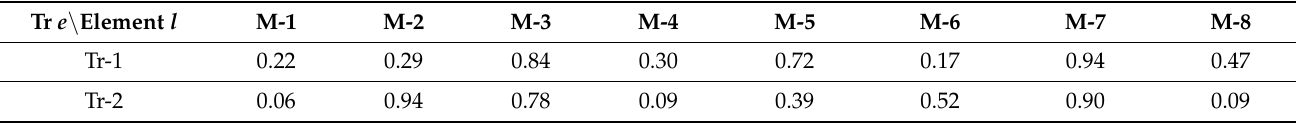
Table 4. Example of initial TR when NP = 2, and I and J =